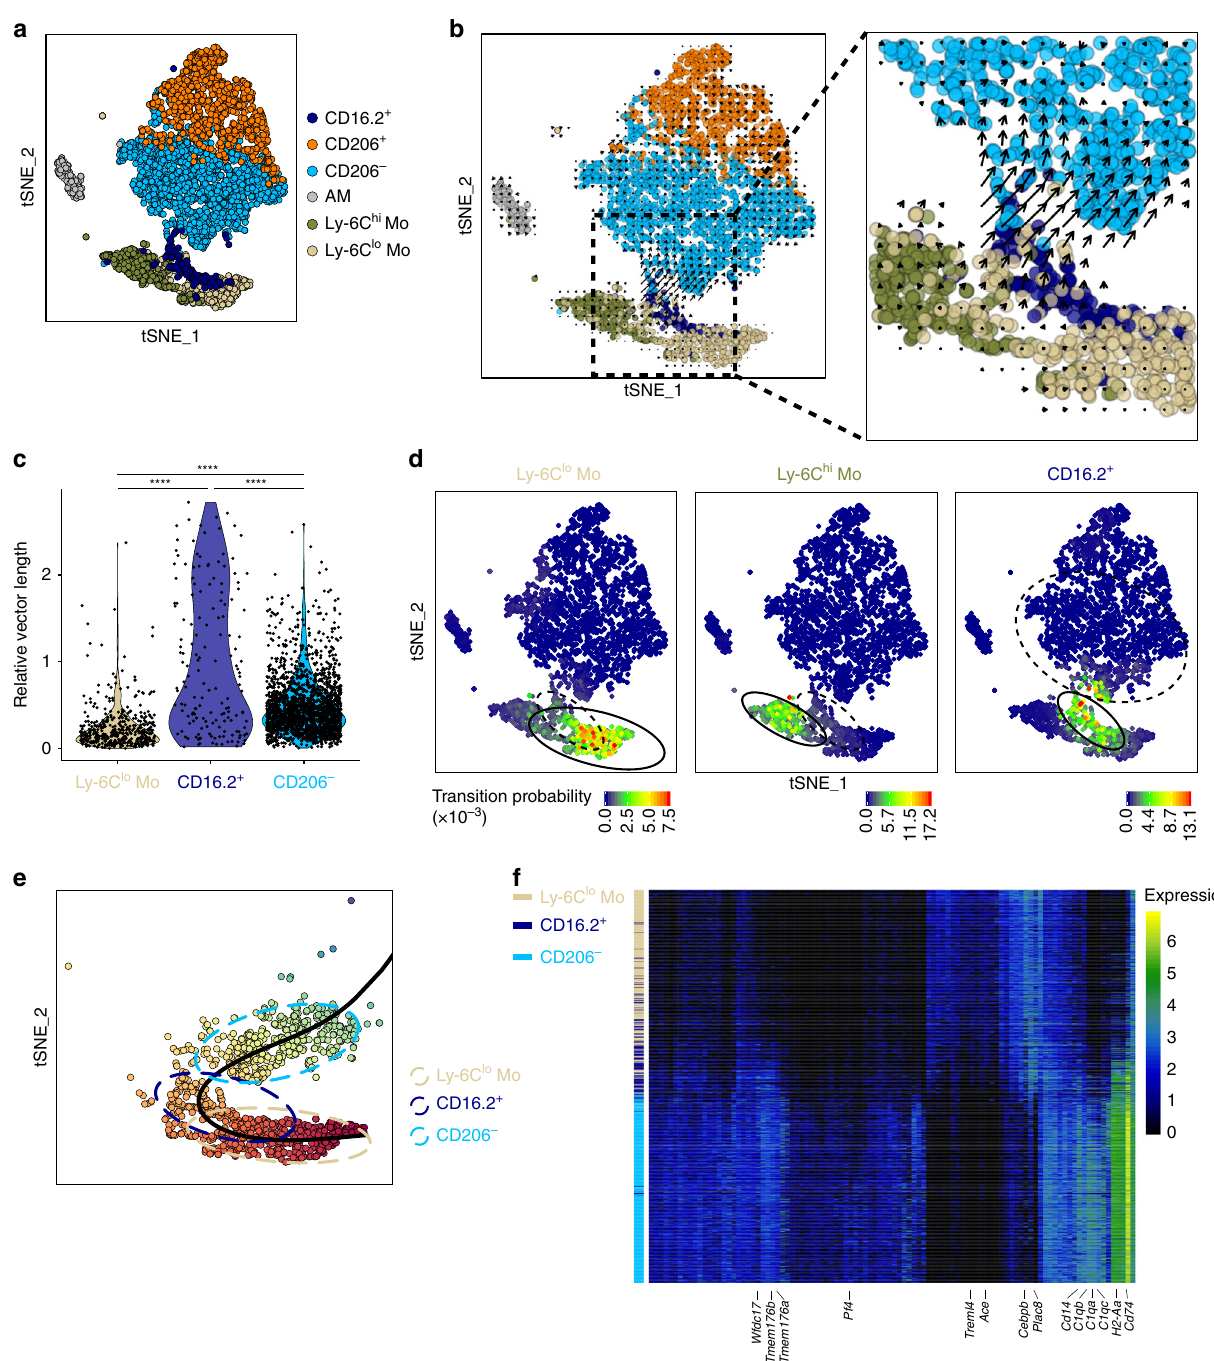
Fig. 6 RNA velocity and trajectory analyses of lung monocyte and IM subpopulations in steady-state C57BL/6 mice. a t- SNE plot depicting the merged scRNA-seq data of lung CD64-expressing cells (see Fig. 1c), Ly-6C lo patrolling monocytes (see Supplementary Fig. 9) and Ly-6C hi classical monocytes (see Supplementary Fig. 12). b Prevalent patterns of RNA velocities substantiated by arrows and visualized on the same t- SNE plot as shown in ( a ). Right panel shows a higher magni fi cation of the area depicted by a black dashed line in the left panel. (see single cell velocities in Supplementary Fig. 13). c Violin plot showing quanti fi cation of single cell relative 2D velocities in the indicated cell (sub)populations, as presented in Supplementary Fig. 13. d Visualization of single-step transition probabilities from Ly-6C lo patrolling monocytes (left), Ly-6C hi classical monocytes (middle) or CD64 + CD16.2 + monocytes (right) to neighboring cells. Ellipses represent 95% con fi dence. e , f Slingshot analysis of Ly-6C lo patrolling monocytes, CD64 + CD16.2 + monocytes, and neighboring CD206 − IM. e Suggested pseudo-time trajectory from Ly-6C lo patrolling monocytes to CD206 − IM. Ellipses represent 80% con fi dence. f Heatmap depicting gene expression pro fi les of Ly-6C lo patrolling monocytes, CD64 + CD16.2 + monocytes, and neighboring CD206 − IM ordered according to Slingshot pseudo-time trajectory. Left color bars indicate annotation by cell type